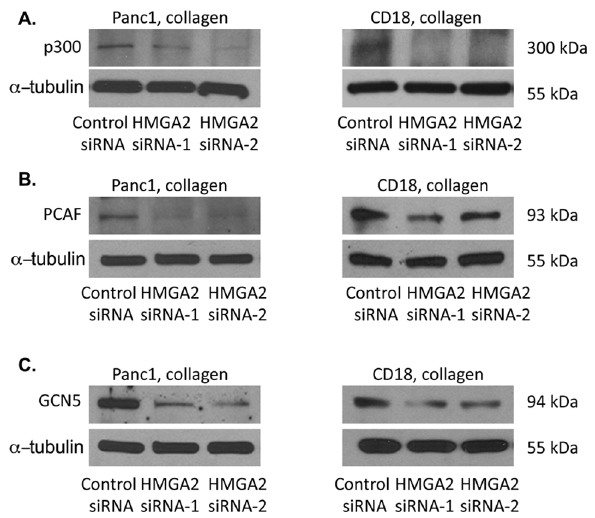
Figure 4. HMGA2 mediates collagen-induced p300, PCAF and GCN5 HAT expression. Panc1 and CD18 cells were transfected with control siRNA or with 2 different HMGA2 siRNAs, allowed to recover overnight and then plated in three-dimensional collagen gels for additional 24 hours. The lysates were then analyzed for p300 ( A ), PCAF ( B ) and GCN5 ( C ) HATs using a -tubulin as loading control. The results are representative of at least three independent experiments.